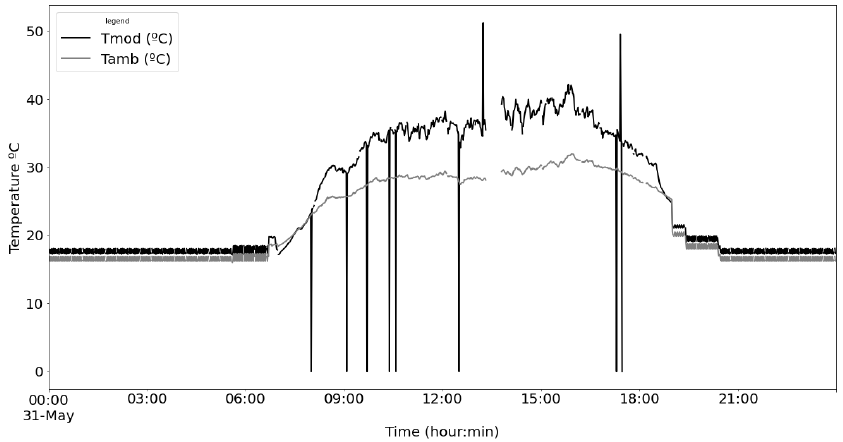
Figure 17. Comparison of PV module temperature vs. ambient temperature.